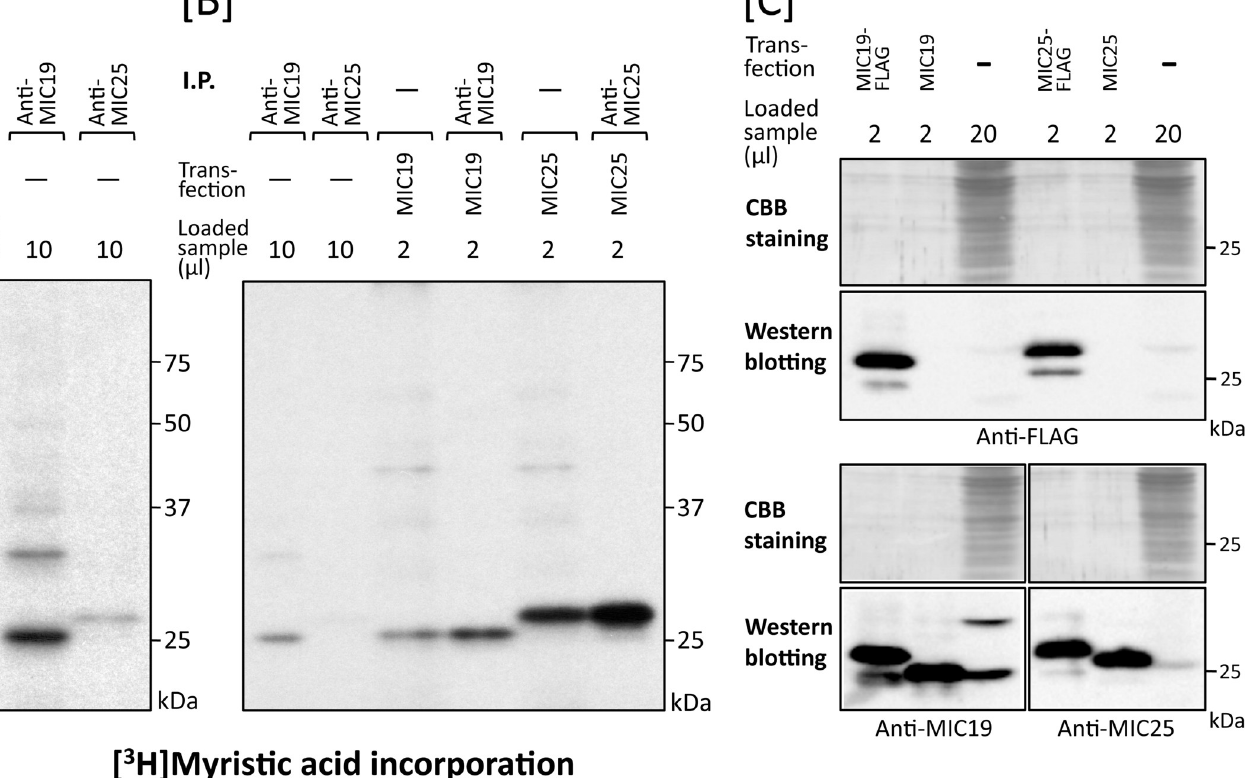
PLOS ONE | https://doi.org/10.1371/journal.pone.0206355 November14,